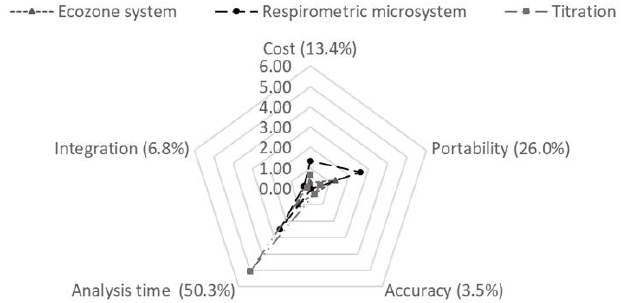
Figure 9. Radar chart for respirometric methods scores with respect to the analytic hierarchy process criteria.